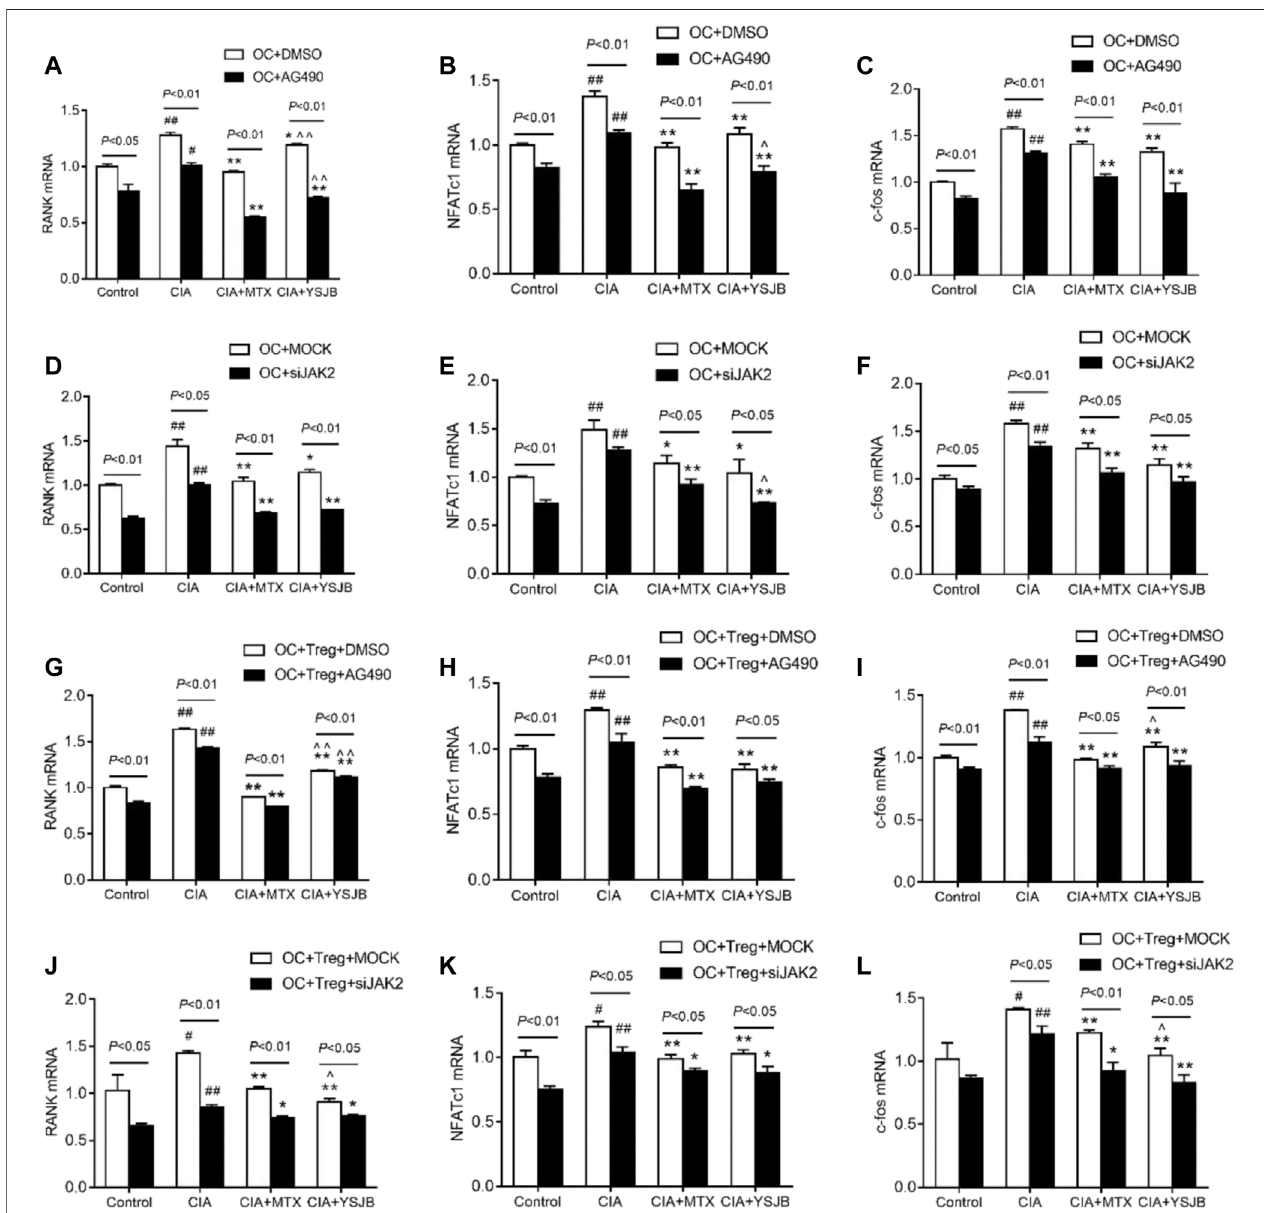
FIGURE 7 | YSJB , AG490 and JAK2 siRNA decreased the mRNA levels of RANK, NFATc1, and c-fos, which were associated with the differentiation and maturation of OCs. (A – F) The mRNA levels of RANK, NFATc1, and c-fos in the OC single culture system. (G – L) The mRNA levels of RANK, NFATc1, and c-fos in the coculture system. Cells were treated with drug-containing serum, AG490 or JAK2 siRNA. # p < 0.05, ## p < 0.01 compared with the control group; * p < 0.05, ** p < 0.01 compared with the CIA group; ^ p < 0.05, ^^ p < 0.01 compared with the CIA+MTX group.